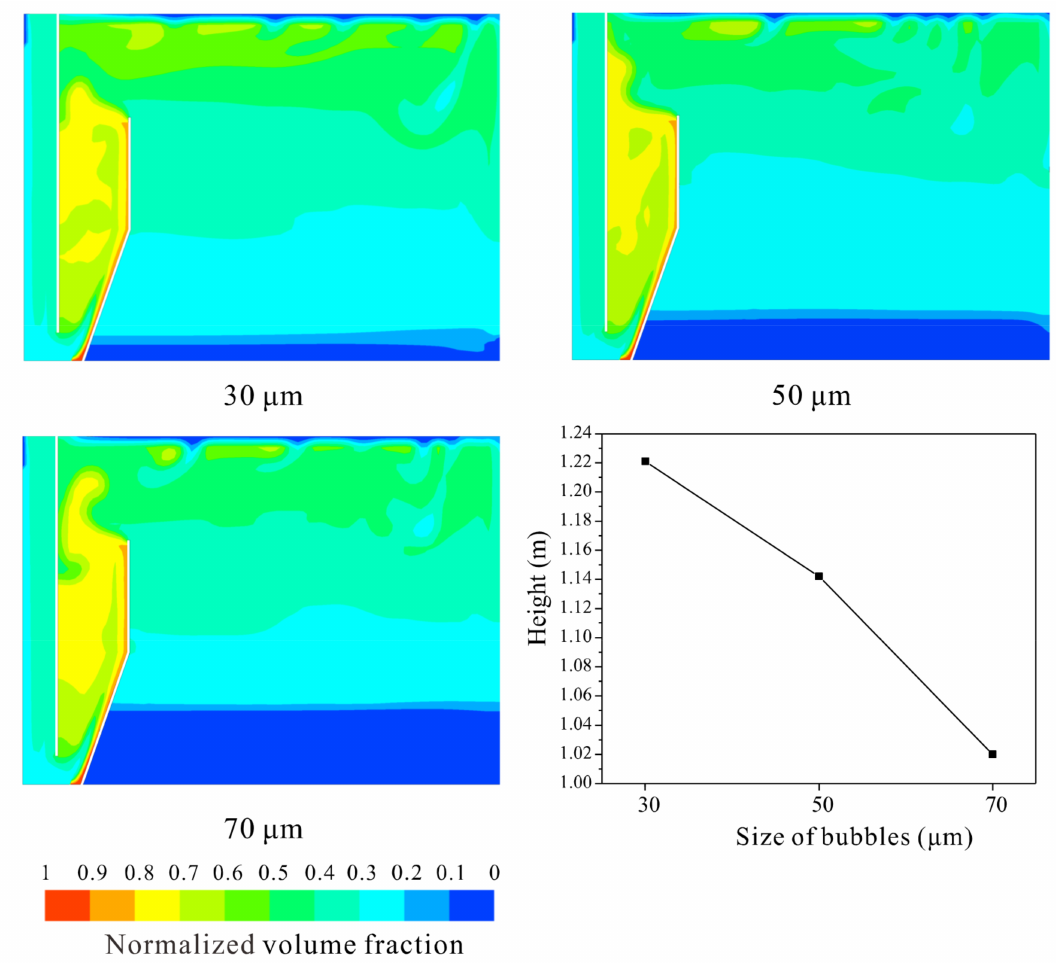
Figure 7. Effect of the size of bubble on air